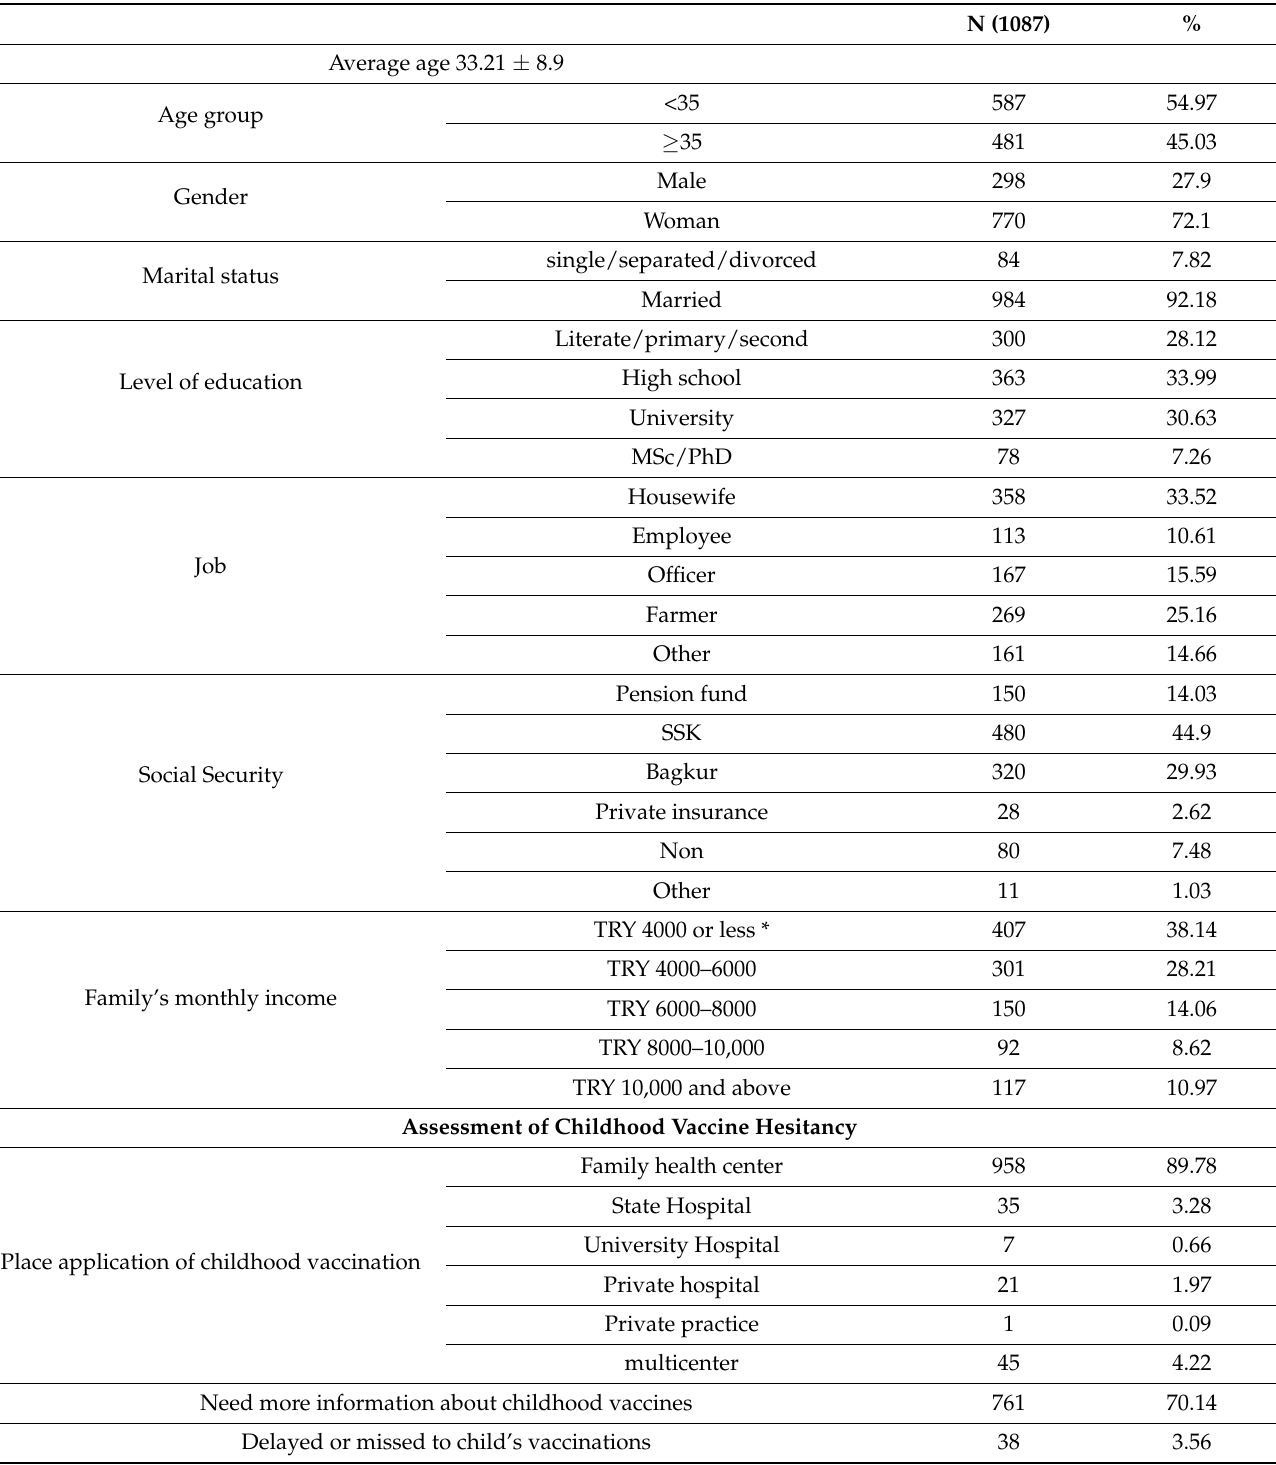
Table 1. Descriptive Characteristics of the